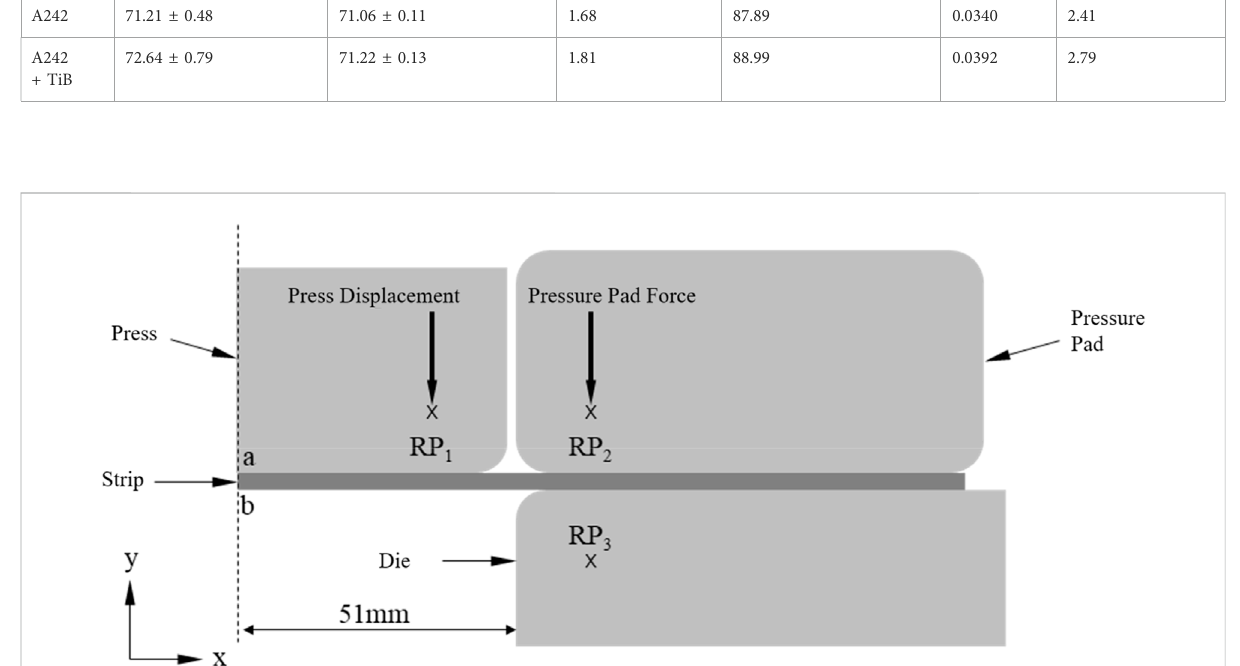
Geometry of the FE simulation model.